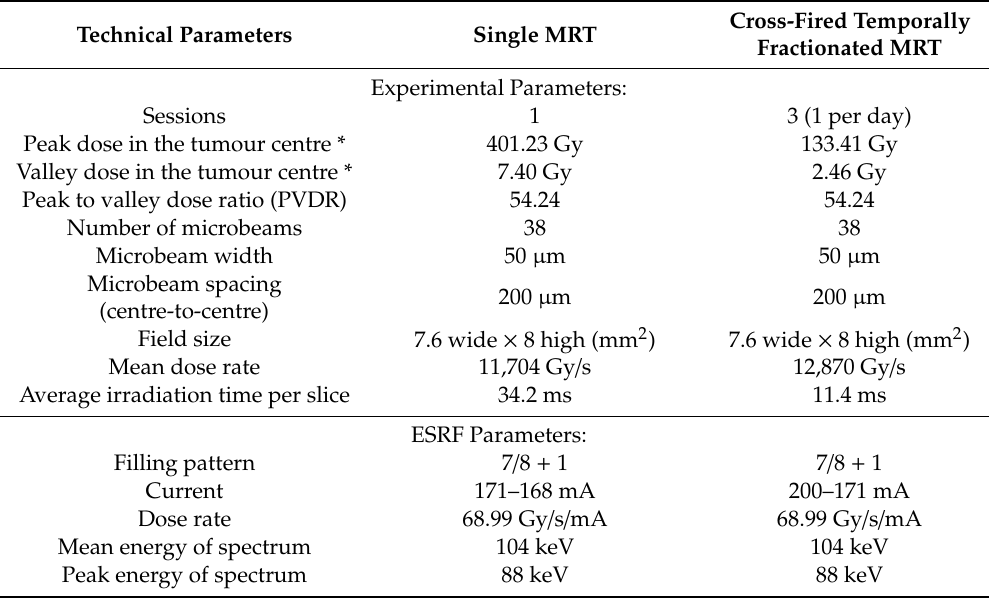
Table 1. Experimental